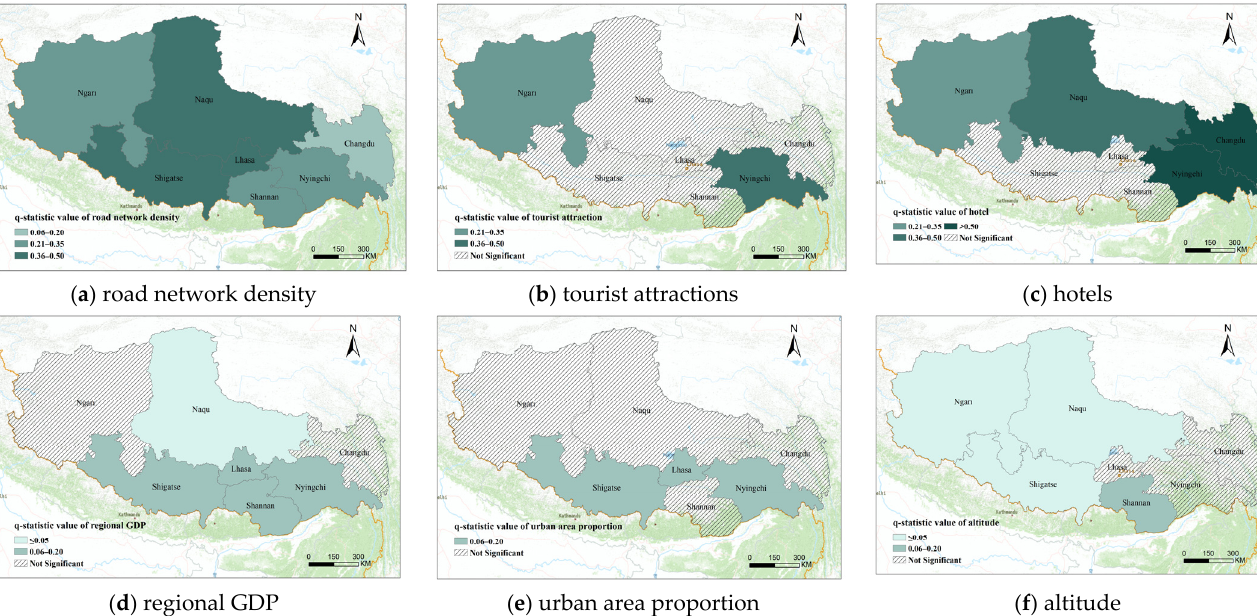
Figure 10. q -statistics of factors by city in Tibet Figure 10. q -Statistics of factors by city in